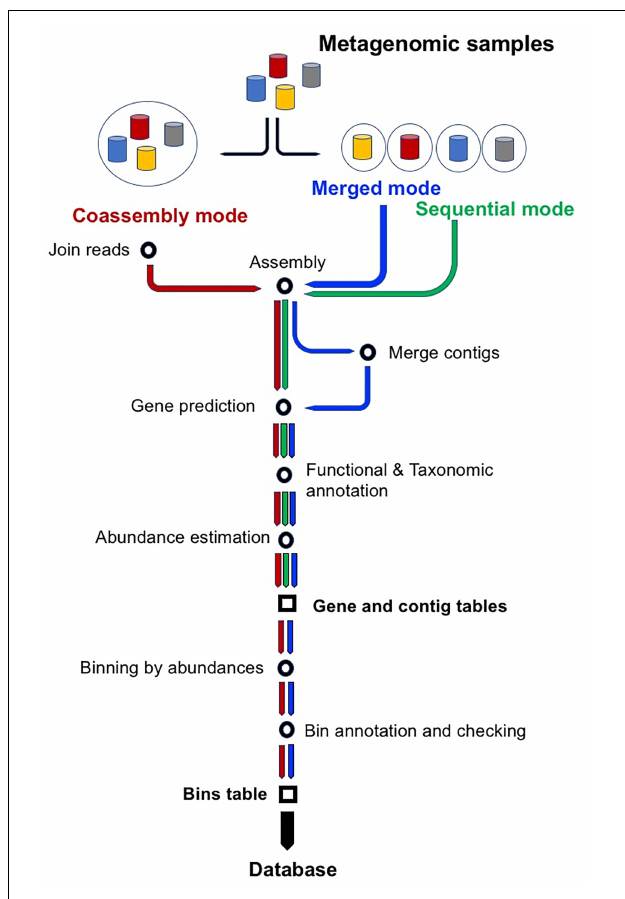
FIGURE 1 | Workflow of the three modes of operation of SqueezeMeta: sequential, co-assembly and merged. Starting from metagenomic samples, green, blue and red arrows indicate main steps in sequential, merged and co-assembly modes. All modes create two of the three main results tables: ORF and contig tables. Co-assembly and merged modes also apply binning and, therefore, they also create the bin